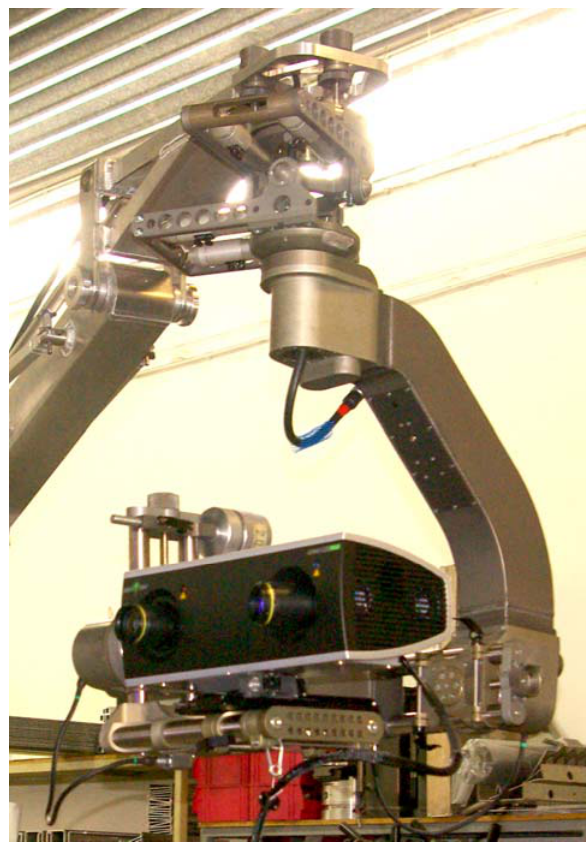
Picture 3. L3D on the gyroscope ©by G.Gresik